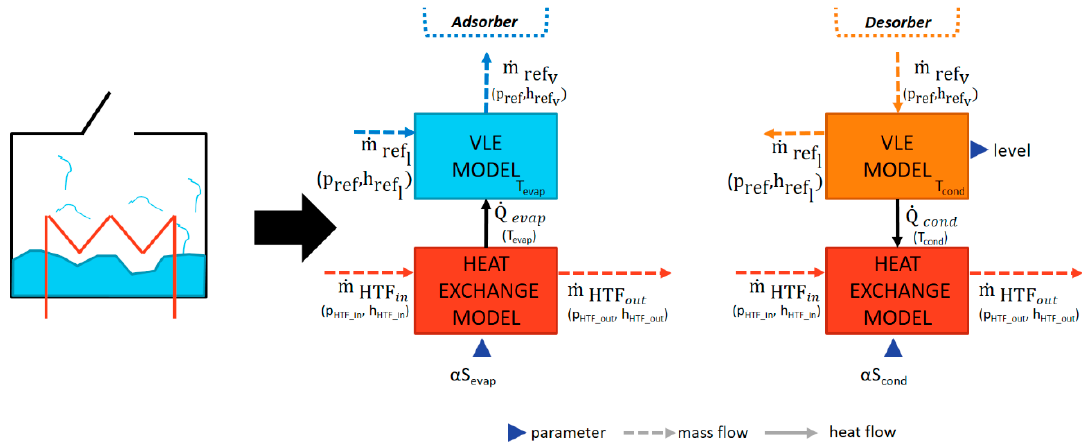
Figure 3. Schematics of the adsorber (left) and its implementation, with input and output variables and energy flows for the adsorber during adsorption (middle) and desorption (right).